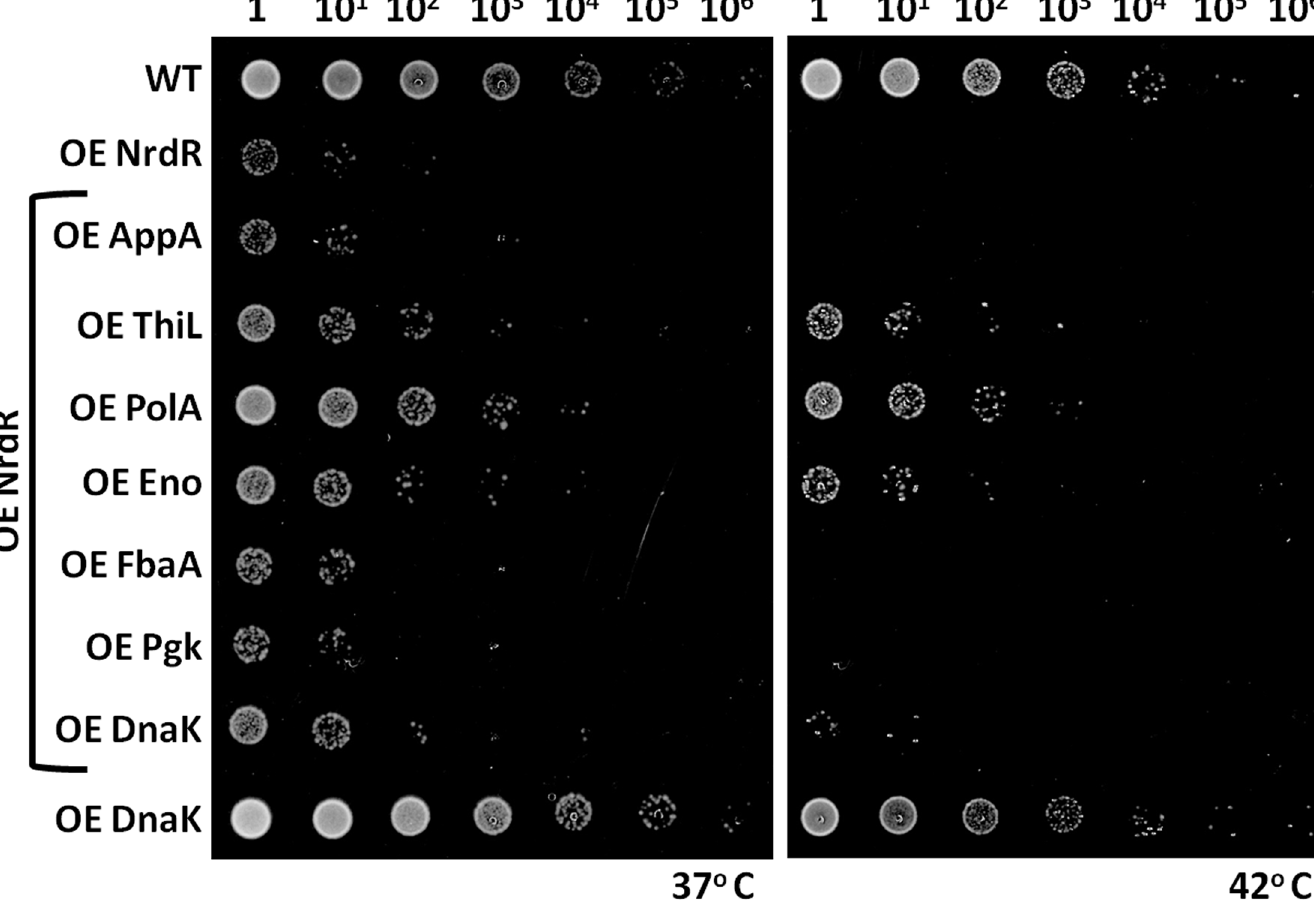
Fig 6. Complementary expression of PolA, ThiL & Eno shows partial rescue of the bacterial fitness defect caused by NrdR overexpression. The downregulated essential genes of Appa, ThiL, PolA, Eno, FbaA and Pgk were complementarily expressed under the NrdR overexpression background to test fitness rescue. Partial rescue of bacterial fitness was observed for PolA, Thil or Eno complementary expression. Complementary expression of genes Appa, FbaA and Pgk resulted in fitness defects resembling those of NrdR overexpression alone and did not result in fitness rescue. Empty vectors pET-duet (Kan + ) and pCA24N (Cam + ) were transformed into WT strains as controls. The E . coli with DnaK overexpression was used as both negative and positive controls by excluding or incorporating NrdR overexpression, respectively. Dilution factors for the E . coli cultures are labeled over the